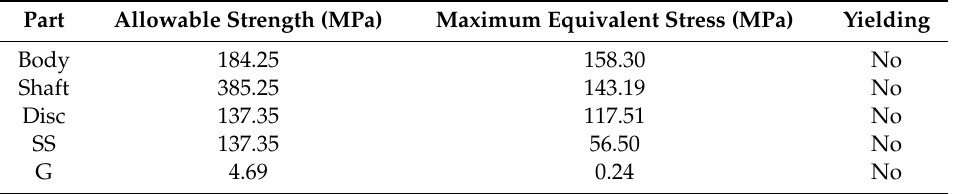
Table 9. Structural safety of the proposed TOBV.